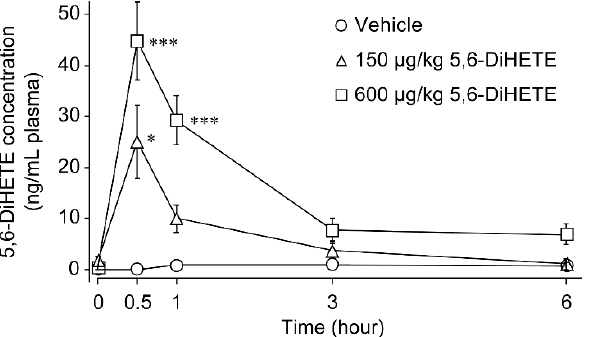
Figure 1. Pharmacokinetics of 5,6-DiHETE in plasma after oral administration. Plasma samples were collected before and 0.5, 1, 3 and 6 h after dosing 150 or 600 µ g/kg of 5,6-DiHETE or vehicle (n = 8 per group). The concentration of 5,6-DiHETE was measured with LC/MS. Data are represented as mean ± SEM. * p < 0.05, *** p < 0.001 compared with Vehicle.